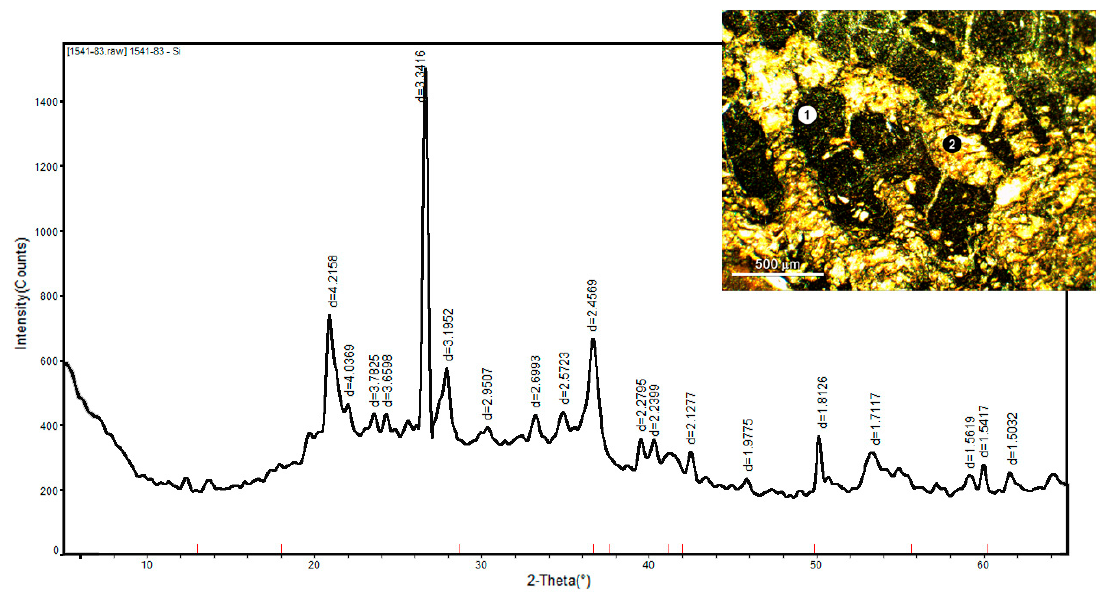
Figure 3. X-ray diffraction analysis pattern of the buried nodule 1541_83 and the reflected light image of its inner part. Inset: Fe-vernadite ( 1 ) is replaced by goethite ( 2 ).